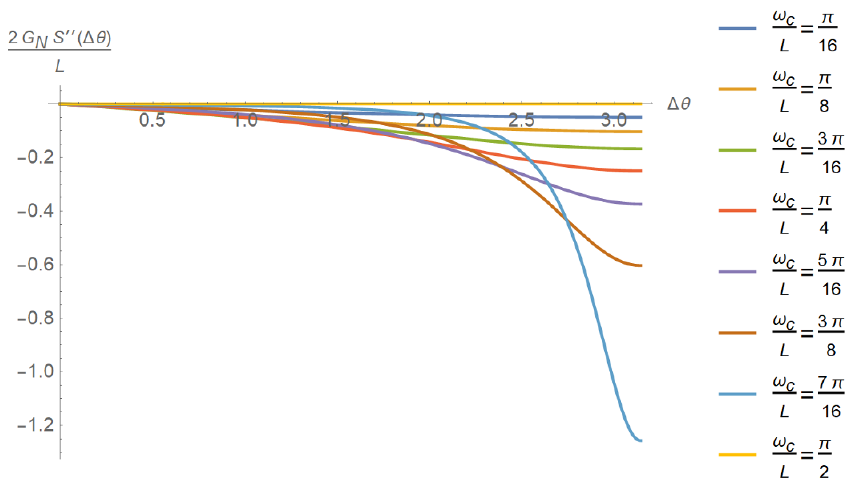
Figure 10 . Strong subadditivity at di(cid:11)erent radial